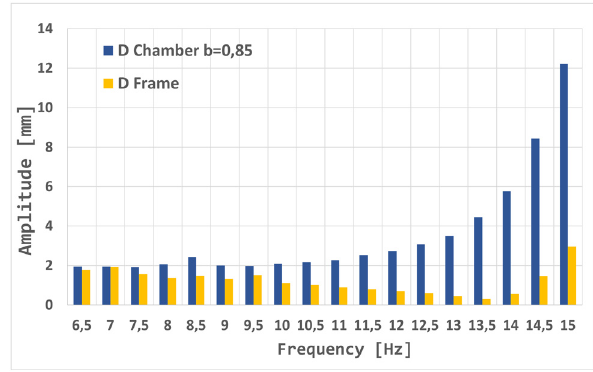
Figure 10: Amplitude – frequency characteristic of the antiresonance mill for the chamber fi lling degree equal to 0.85.